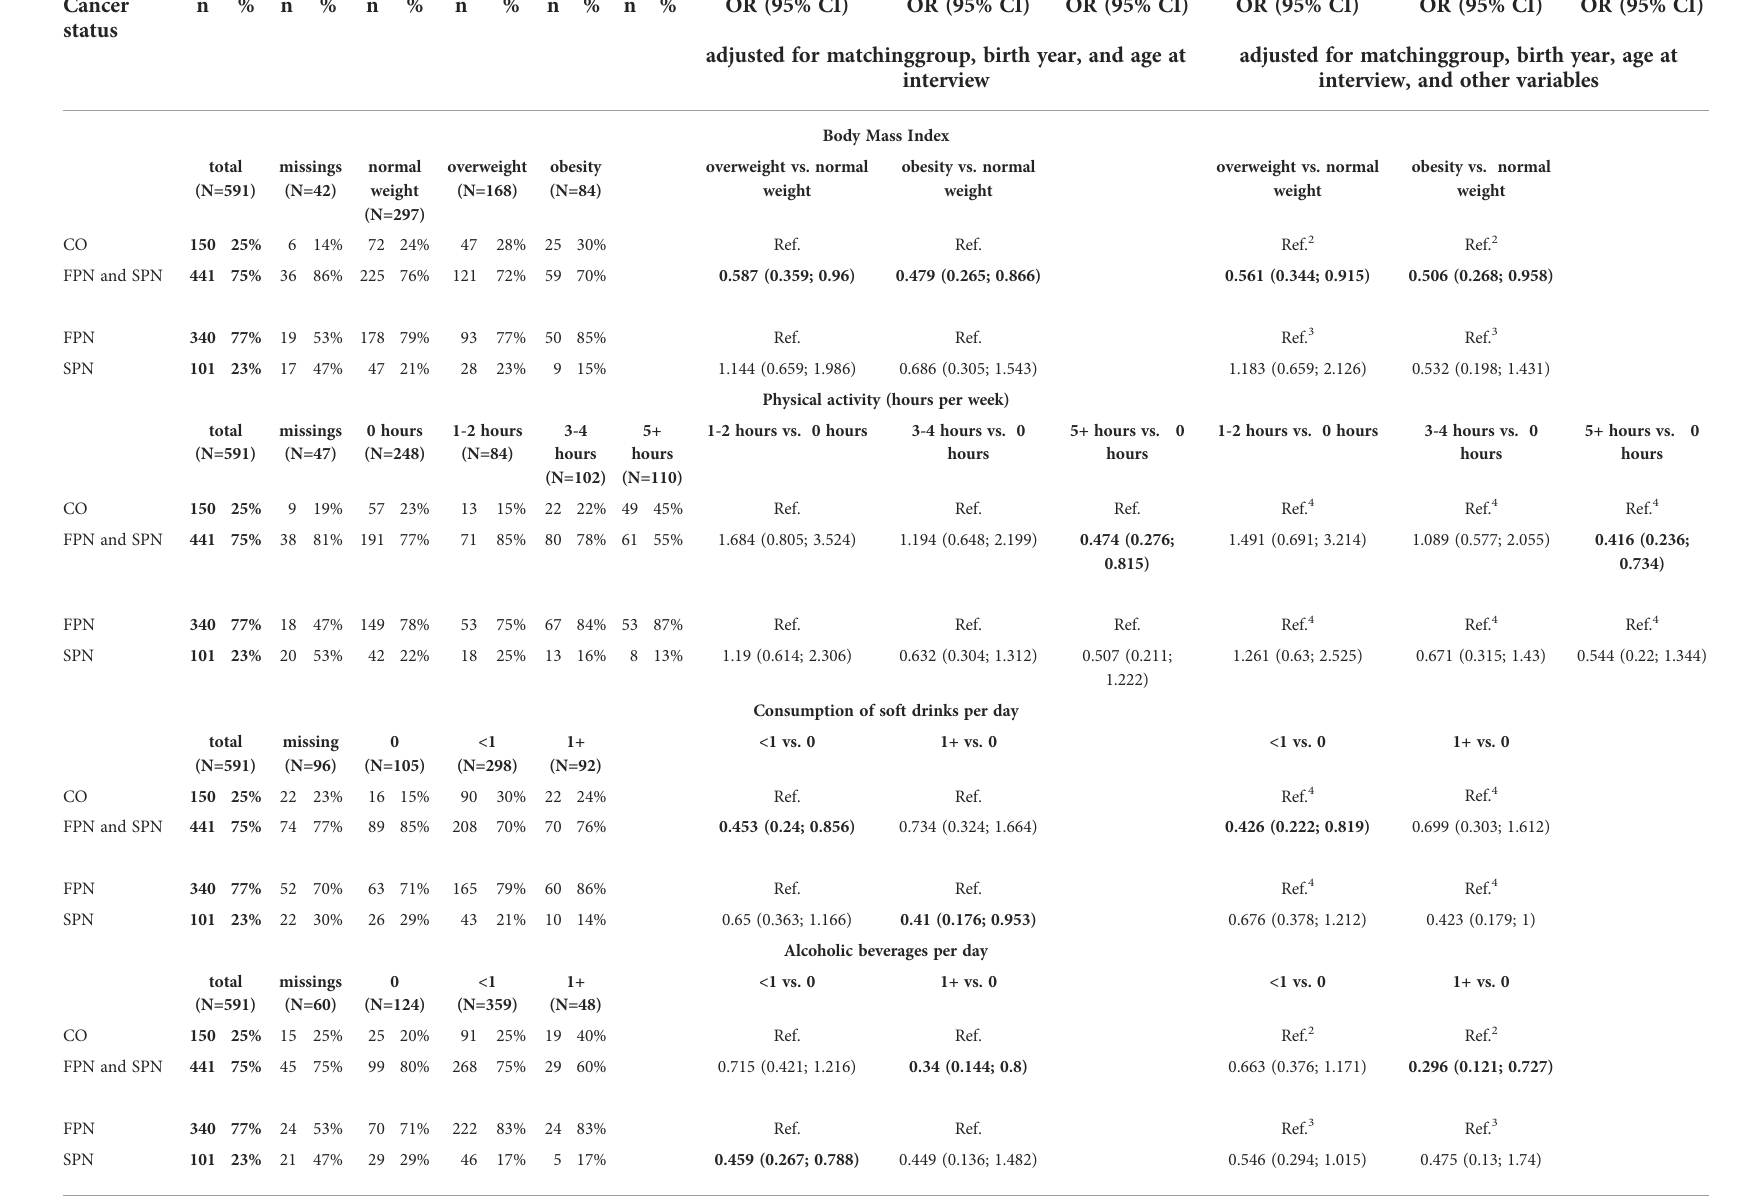
TABLE 3 Multinomial logistic regression on cancer status and risk of late effects 1